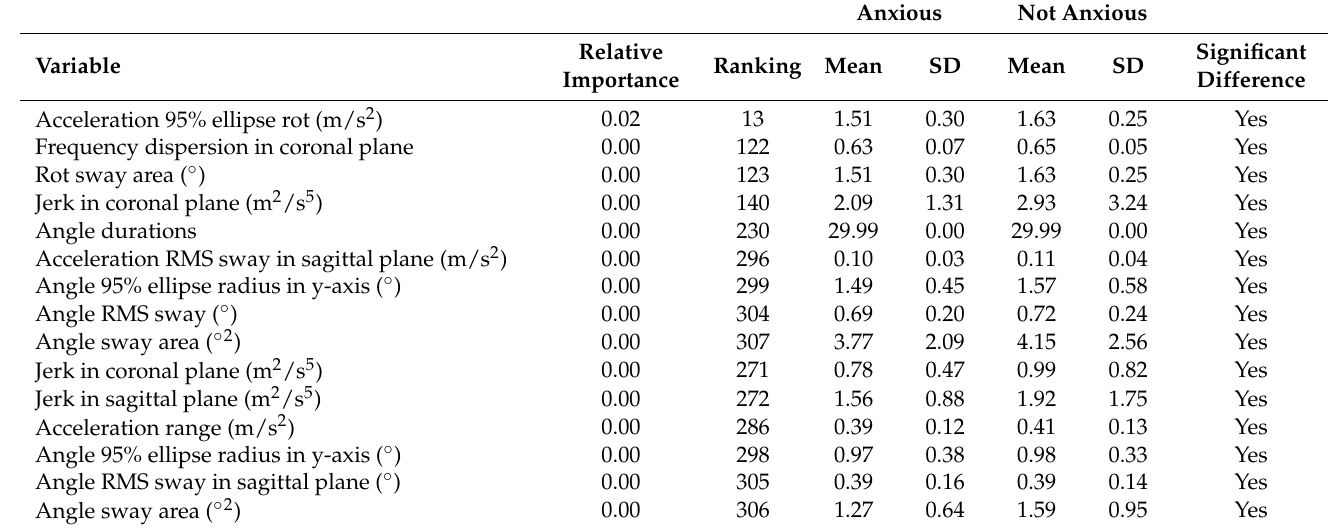
Table 5. Significant Variables Only for Eyes Closed, Feet on Foam